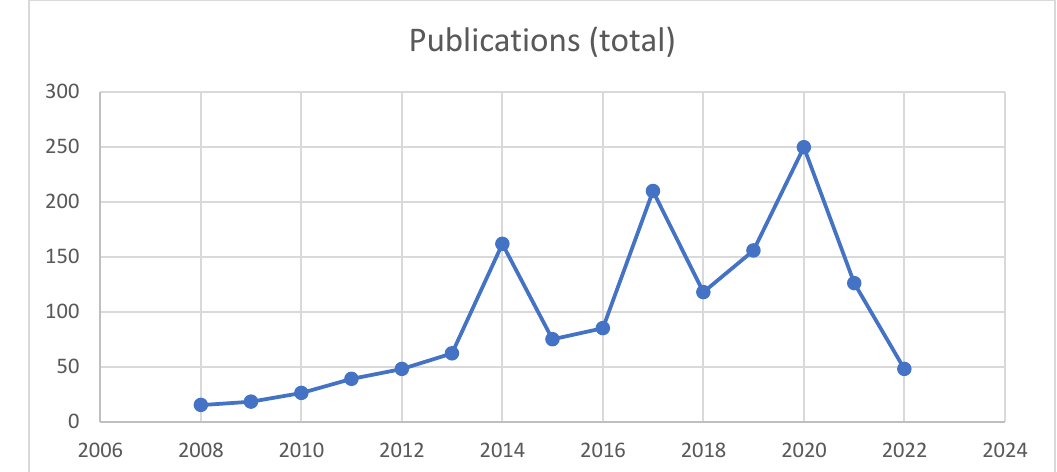
Figure 5 . Overview of the publication (2008-2022) .